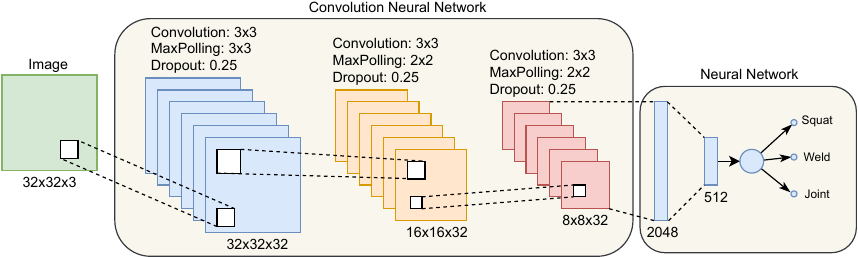
Figure 6. Architecture diagram of a convolutional neural